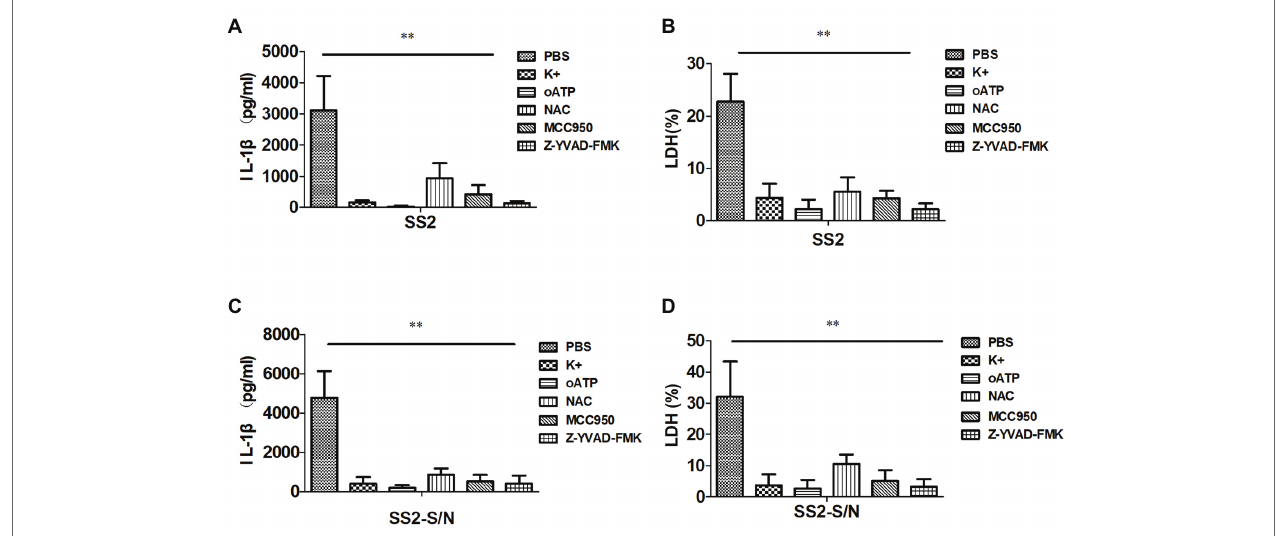
FIGURE 5 | SS2-induced IL-1 β secretion in BMDMs requires potassium (K + ) efflux, ATP, and reactive oxygen species (ROS) production. BMDMs were infected with SS2 (MOI, 1) 16 h in the absence or presence of the K + efflux blocker (KCl, 50 mM), ATP blocker (oxidized ATP, oATP, 500 μ M), ROS inhibitor (N-acetyl-L-cysteine, NAC, 20 mM), Nlrp3 inhibitor (MCC950, 10 μ M), and Caspase-1 inhibitor (Z-YVAD-FMK, 10 μ M). IL-1 β in the supernatants was measured with ELISA (A) and LDH was assayed using a Cytotox96 kit (B) . BMDMs were also incubated with SS2-S/N 16 h after lipopolysaccharide (LPS) priming for 3 h in the absence or presence of the above-mentioned inhibitors. The IL-1 β in the supernatants was measured with ELISA (C) , and LDH was assayed using a Cytotox96 Kit (D) . The results are represented as the means ± standard deviations of three independent experiments. * p < 0.05; ** p <